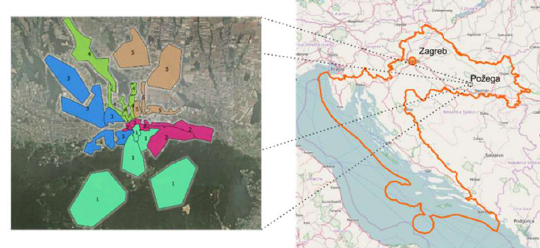
Figure 2. Location of City of Požega within Croatian